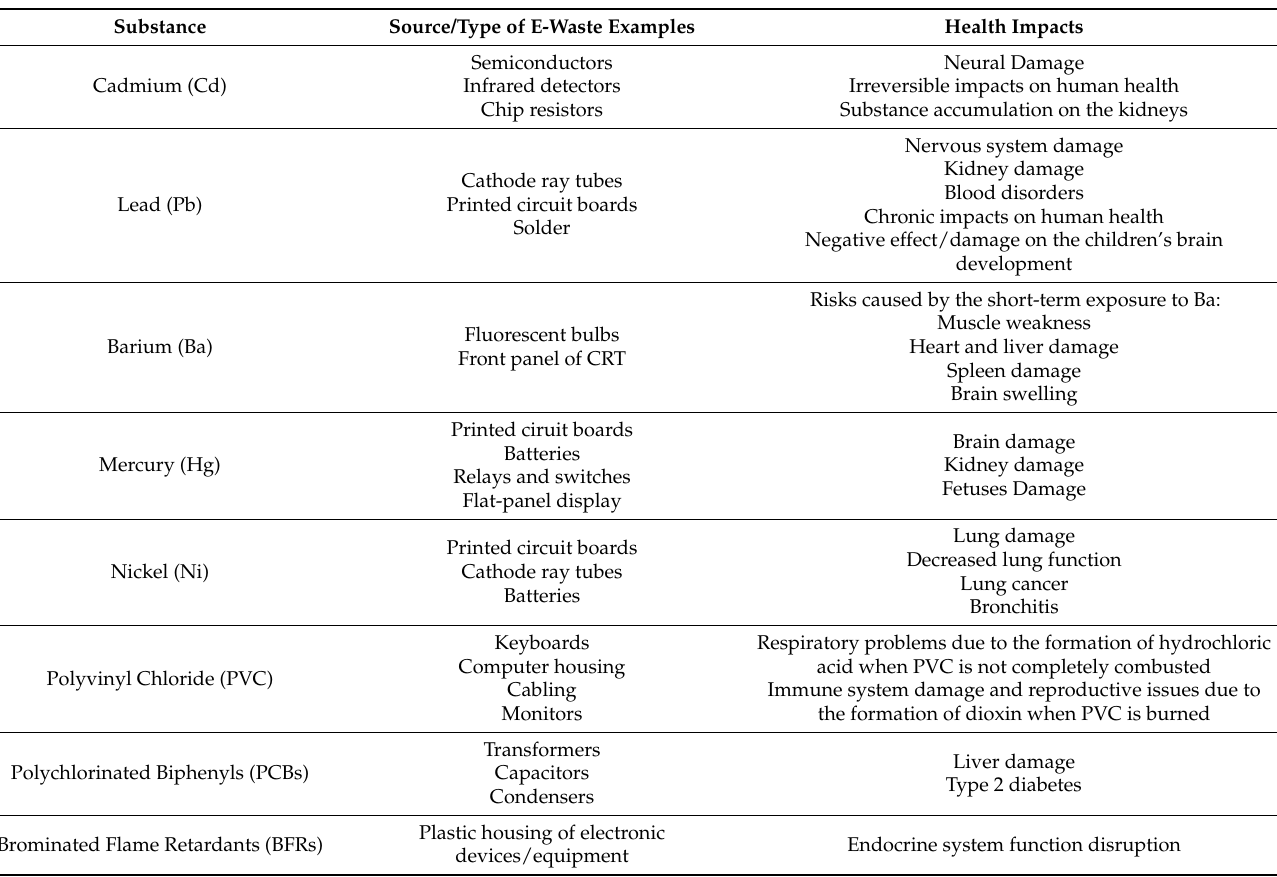
Table 1. Negative health impacts associated with e-waste common toxic